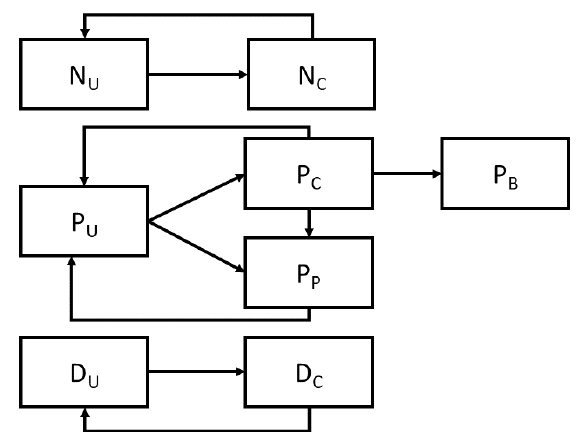
Schematic representation of the compartmental flow of a mathematical model of methicillin-resistant Staphylococcus aureus transmission in an intensive care unit. Arrows indicate possible transition states. Nurses and doctors are classified as uncontaminated or contaminated (N U /D U and N C /D C respectively), while patients may be uncolonized (P U ), colonized (P C ), temporarily protected from colonization (P P ) and bacteremic (P B ).